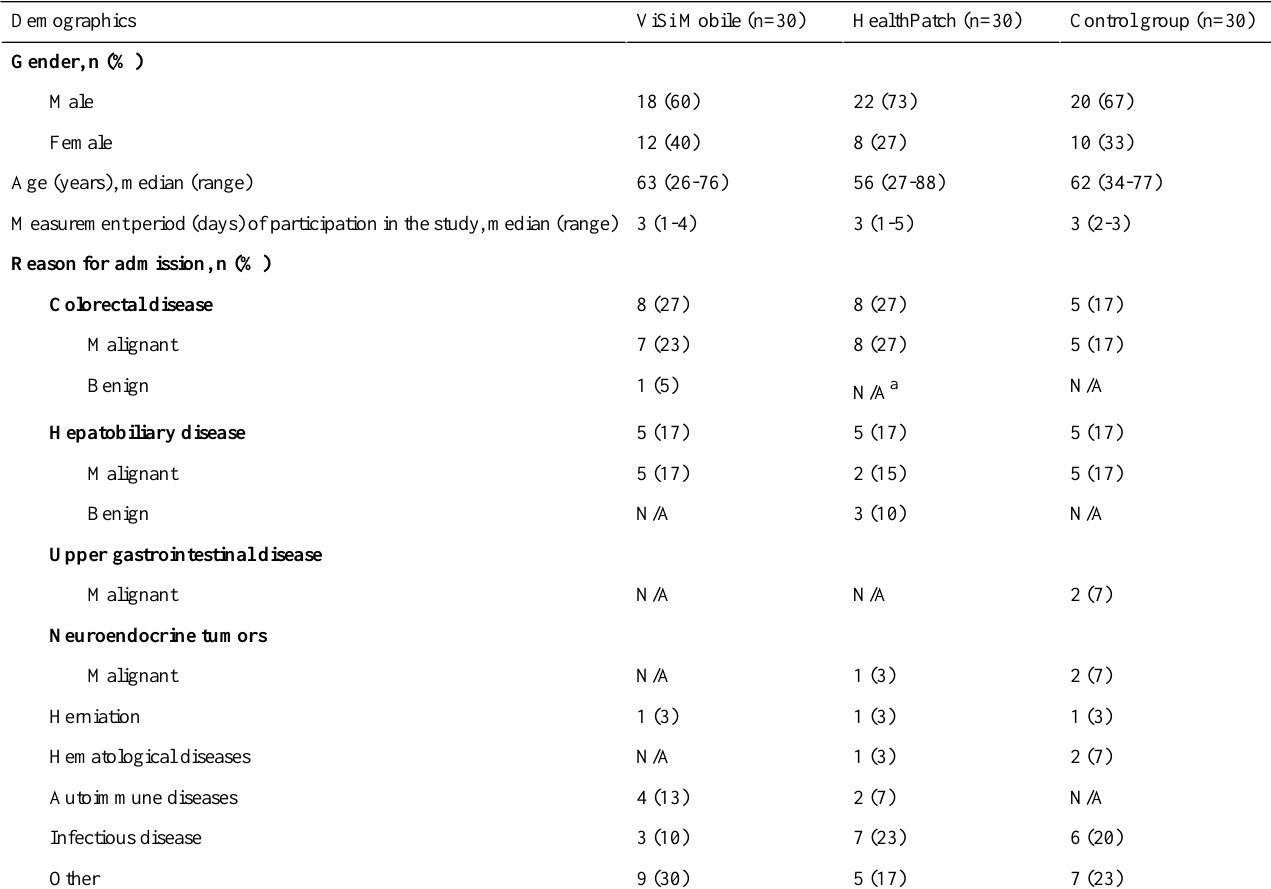
Table 1. Patient